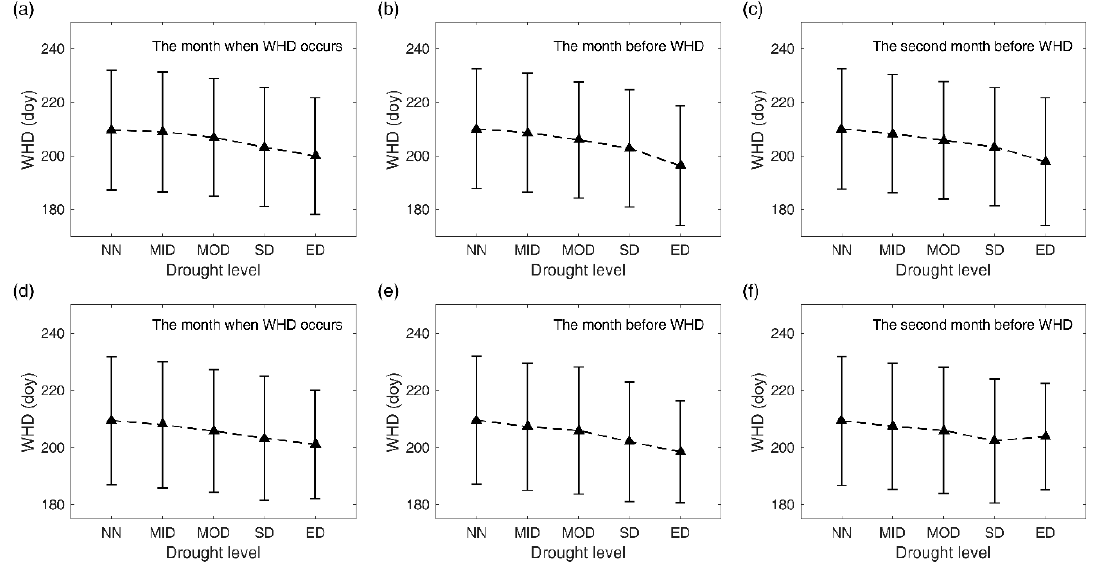
Figure 6. Wheat harvest date comparison at different drought levels in the month when WHD occurs, in the month before WHD, and in the second month before WHD. ( a )–( c ): PDSI; ( d )–( f ): SPEI. NN: near normal; MID: mild drought; MOD: moderate drought; SD: severe drought; ED: extreme drought.